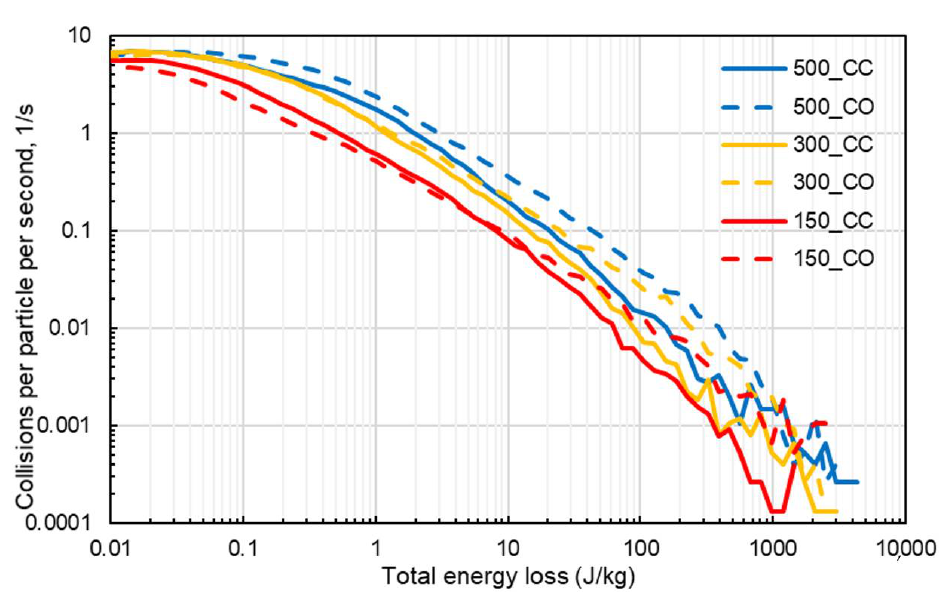
Figure 9. High-energy part of the collision energy spectra for simulations with different values of the impeller speed, for counter-current (solid lines) and co-current (dashed lines) configuration, for simulations with JKR cohesive